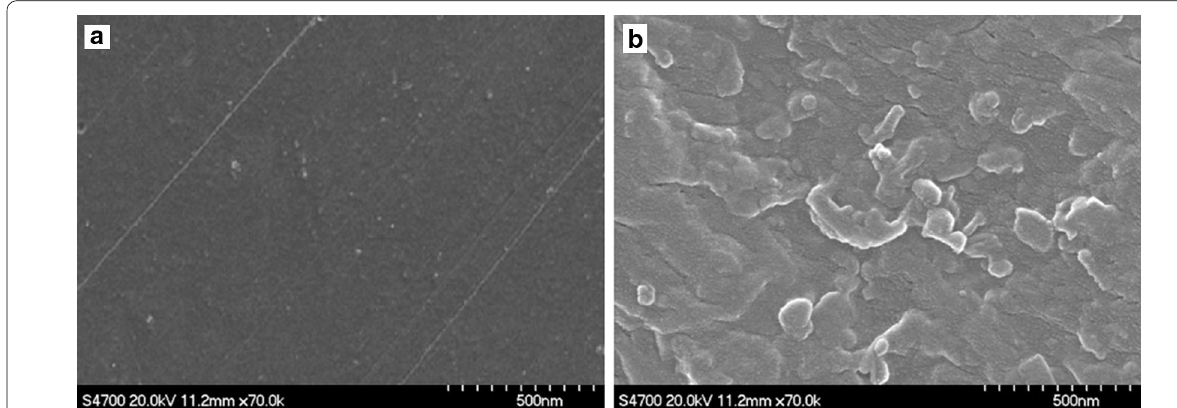
Fig. 5 SEM images of a POC and b POC/Cr NCs containing 7% Cr NPs